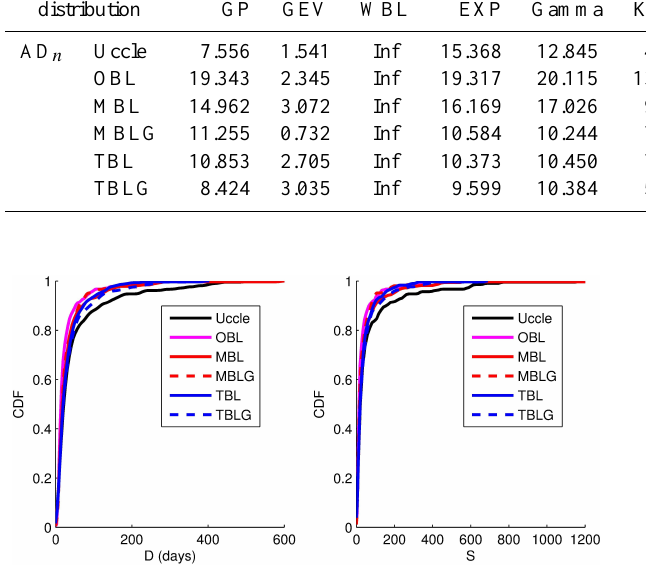
Table 6. Values of the AD n statistic test for some distribution functions fitted to drought duration D and drought severity S . Variable